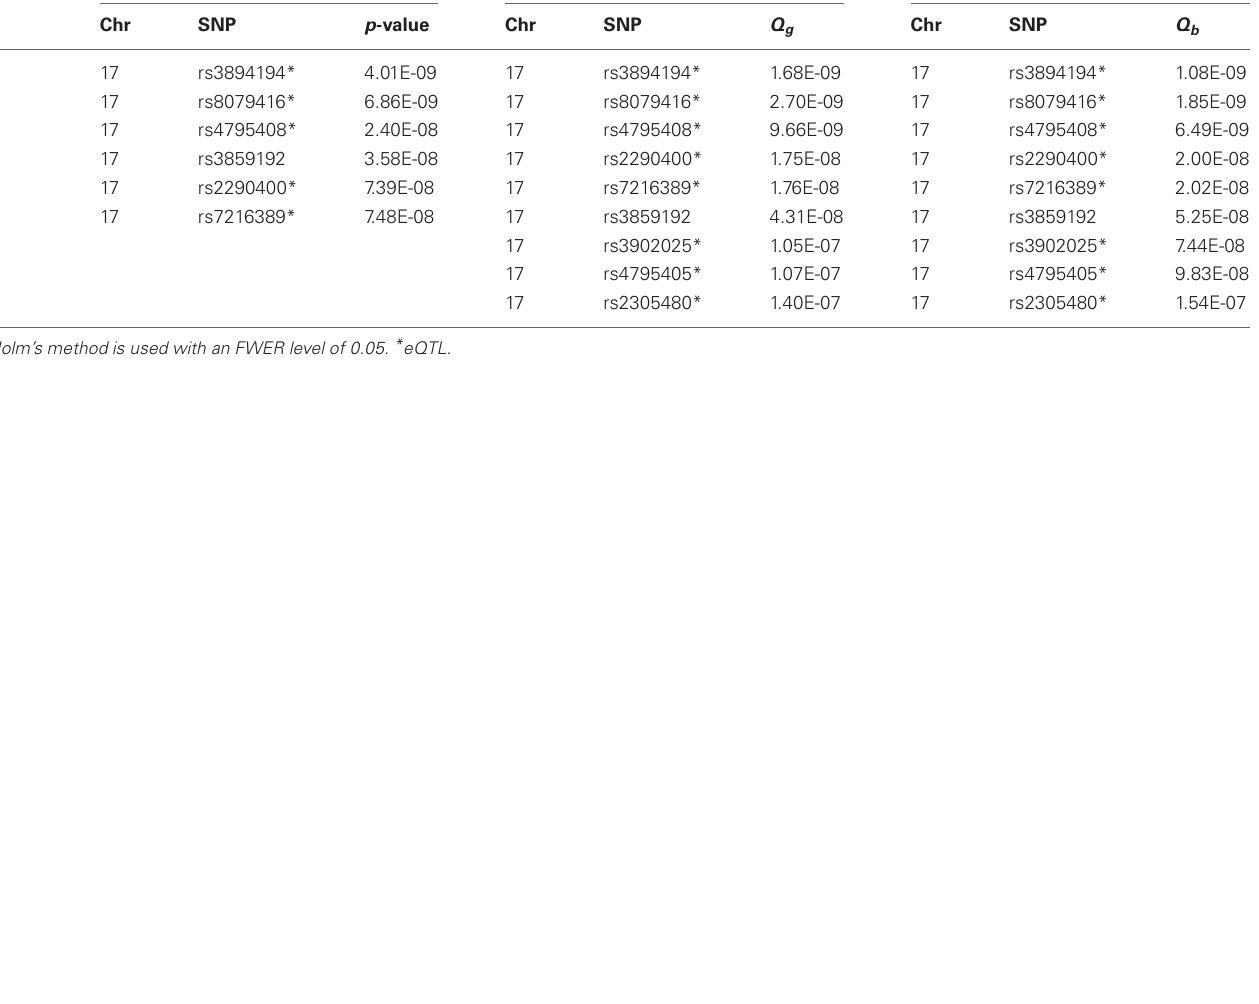
Table A3 | The significant SNPs identified by the unweighted method and the weighted methods (using general weight or binary weight) in the MAGICS analysis.